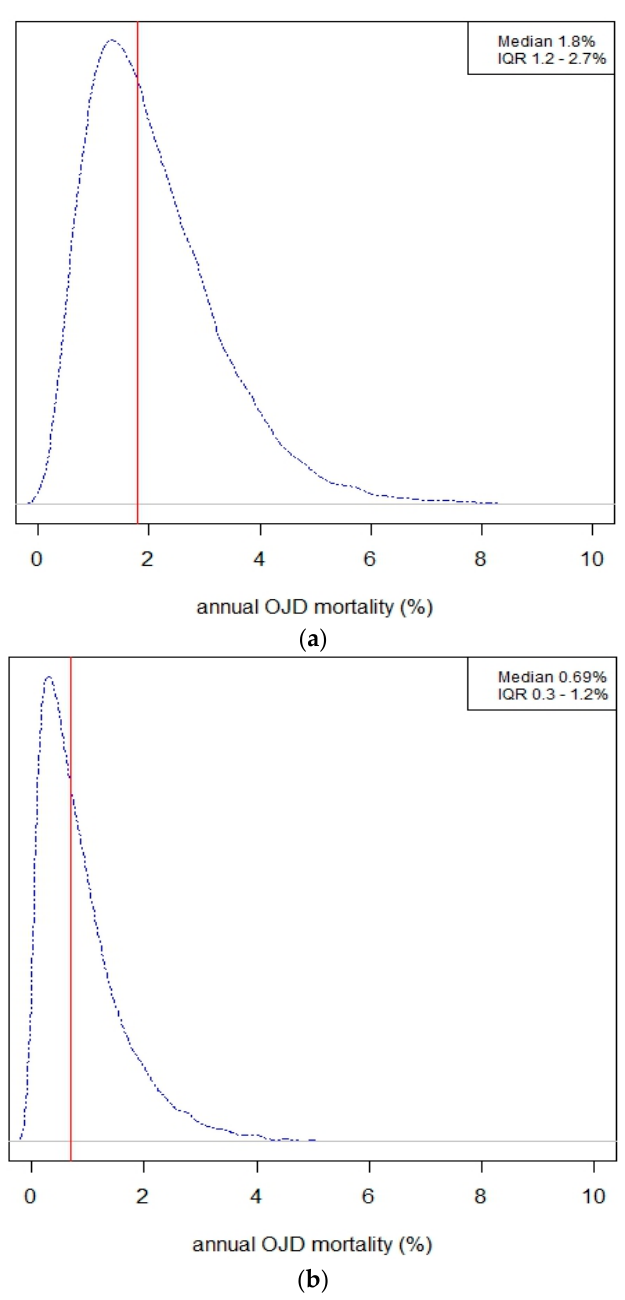
Figure 1. Density plots of estimated annual OJD mortality of ewes in fine-wool ( a ) and other breed ( b ) flocks and interquartile range (IQR, 25th–75th percentiles). The vertical line represents the